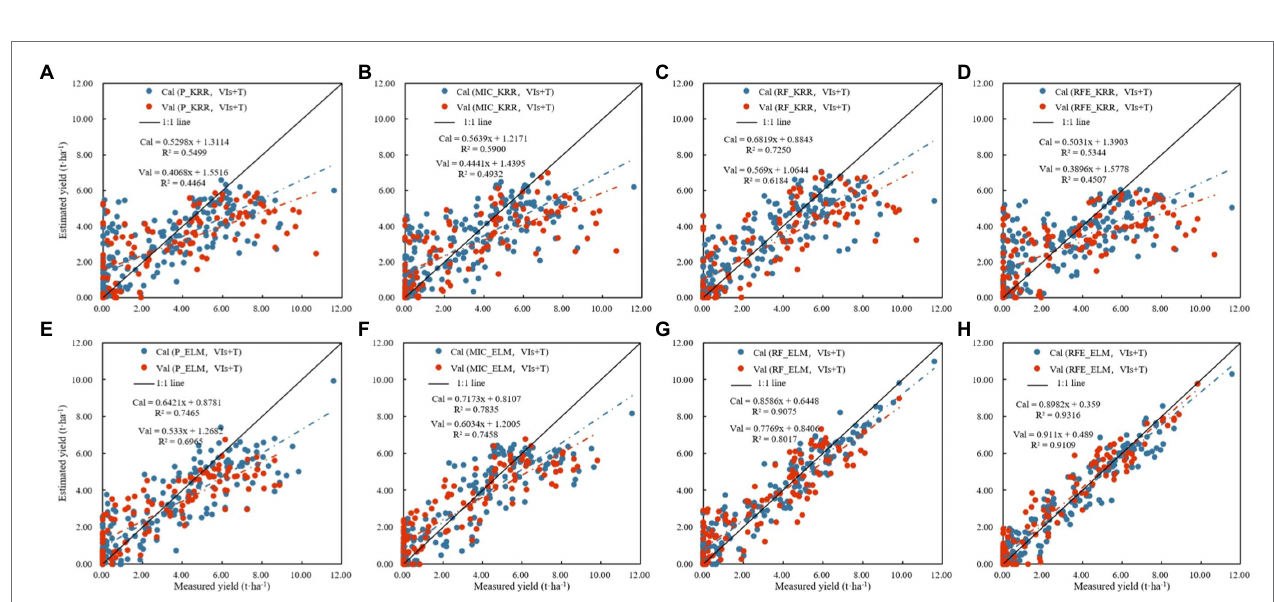
FIGURE 10 | Cotton yield monitoring model based on the fusion of vegetation indices and texture features. (A) Modeling results based on linear regression, (B) modeling results based on nonlinear regression.